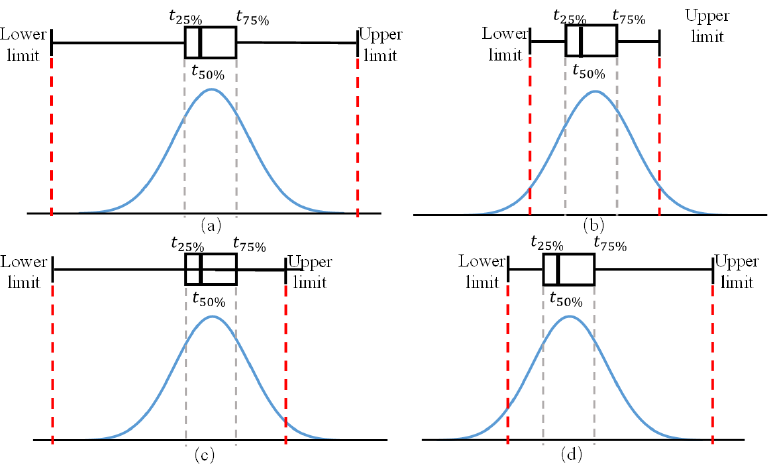
Figure 4. Principle diagram of travel time outlier detection ( a ) Upper and lower limits are outside the normal distribution ( b ) Upper and lower limits are inside the normal distribution ( c ) Lower limit is outside the normal distribution and upper limit is inside the normal distribution ( d ) Lower limit is inside the normal distribution and upper limit is outside the normal